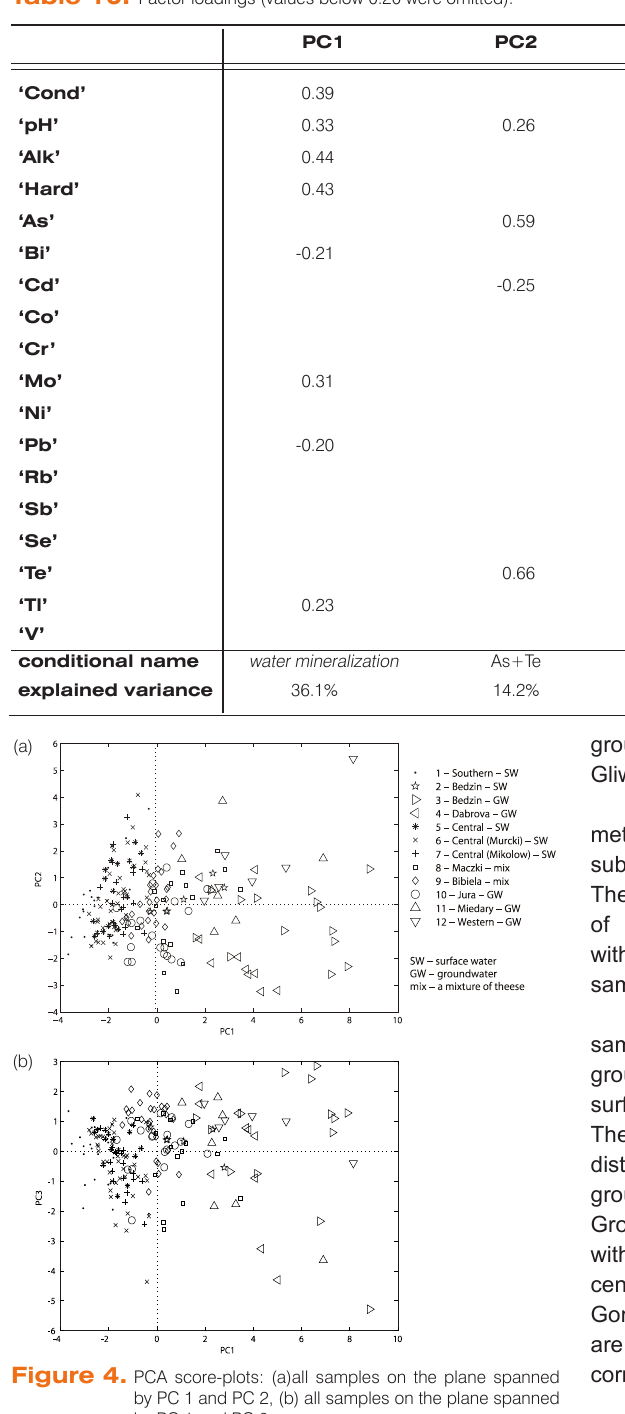
Figure 4. PCA score-plots: (a)all samples on the plane spanned by PC 1 and PC 2, (b) all samples on the plane spanned by PC 1 and